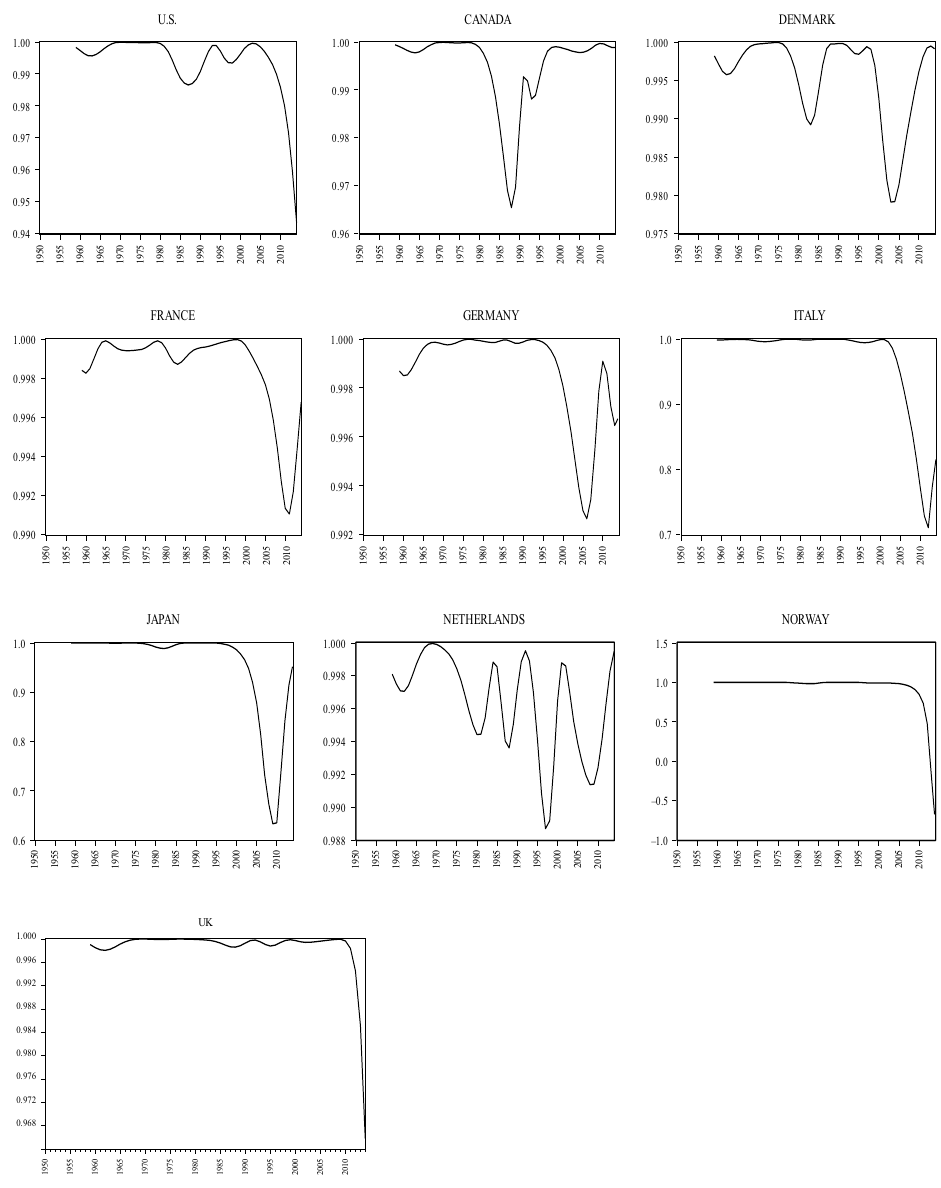
Fig. 3. Rolling correlation analysis between labor productivity and real wages 1950–2014 Source: authors’ calculation using data from The Conference Board Databases – Total Economy Da- tabase and International Labor Comparison program 2016, U.S. Bureau of Labor Statistics, Penn World Table